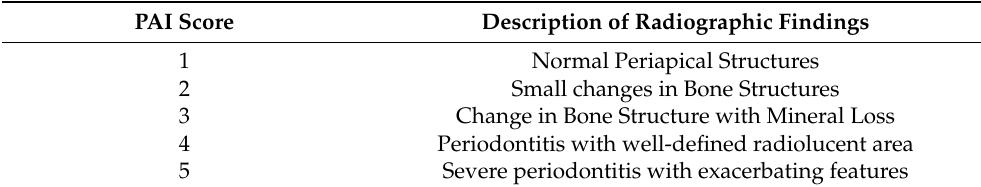
Table 1. Description of Periapical index scores (adapted from Ørstavik et al. [9]). PAI Score Description of Radiographic Findings 1 Normal Periapical Structures 2 Small changes in Bone Structures 3 Change in Bone Structure with Mineral Loss 4 Periodontitis with well-defined radiolucent area 5 Severe periodontitis with exacerbating